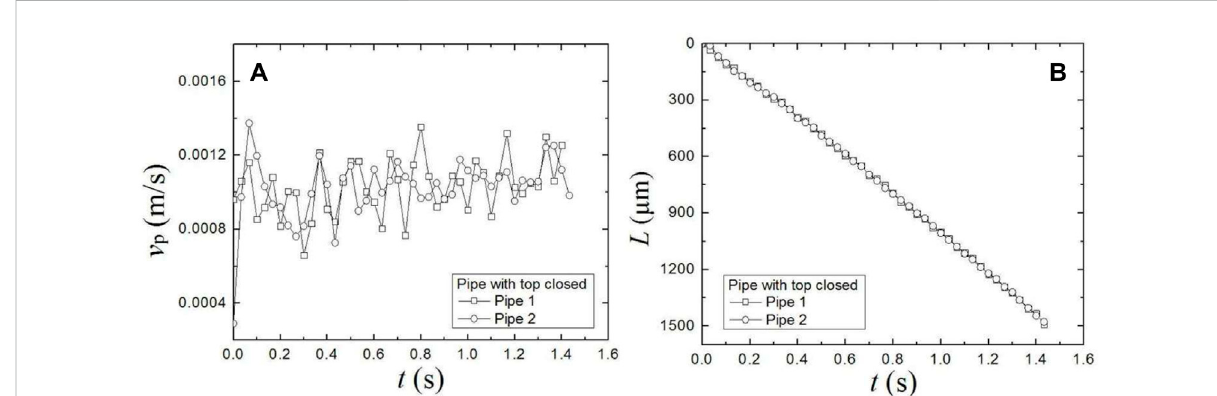
FIGURE 11 (A) DrainvelocityofliquidalongaPlateauborderand (B) measuredinstantaneouspositionofatracerpolyamideparticle fl owingalongthesame Plateau border as functions of time for the foams produced in Pipe 1 (open squares) and Pipe 2 (open circles) both with their tops closed.